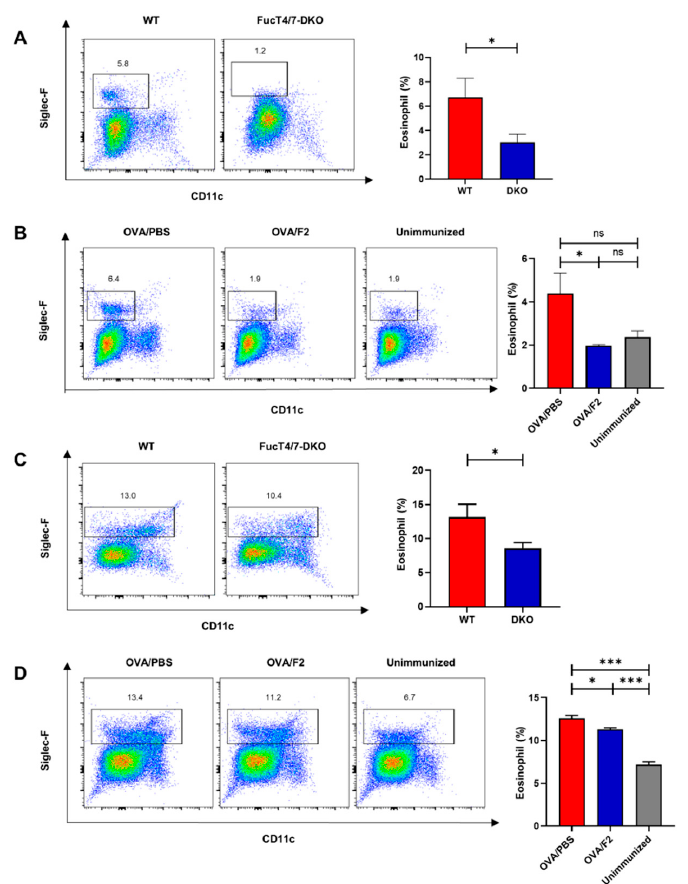
The suppressed eosinophil infiltration to the lung tissue has a possible risk of induc- ing eosinophilia in the blood. To examine this possibility, the peripheral blood from WT and DKO mice was analyzed using flow cytometry (Figure 5A). Surprisingly, however, the percentage of eosinophils in the blood from the immunized DKO mice was signifi- cantly lower than that from the WT mice, indicating that eosinophilia was not observed in the DKO mice. Furthermore, the percentage of eosinophils was significantly increased in the peripheral blood of the immunized control group, but not in the F2-administered group compared to that observed in unimmunized mice (Figure 5B). These results suggest that eosinophil differentiation was upregulated in the bone marrow after the onset of OVA-induced allergic asthma, but was downregulated by the deficiency or blockage of sLe x .